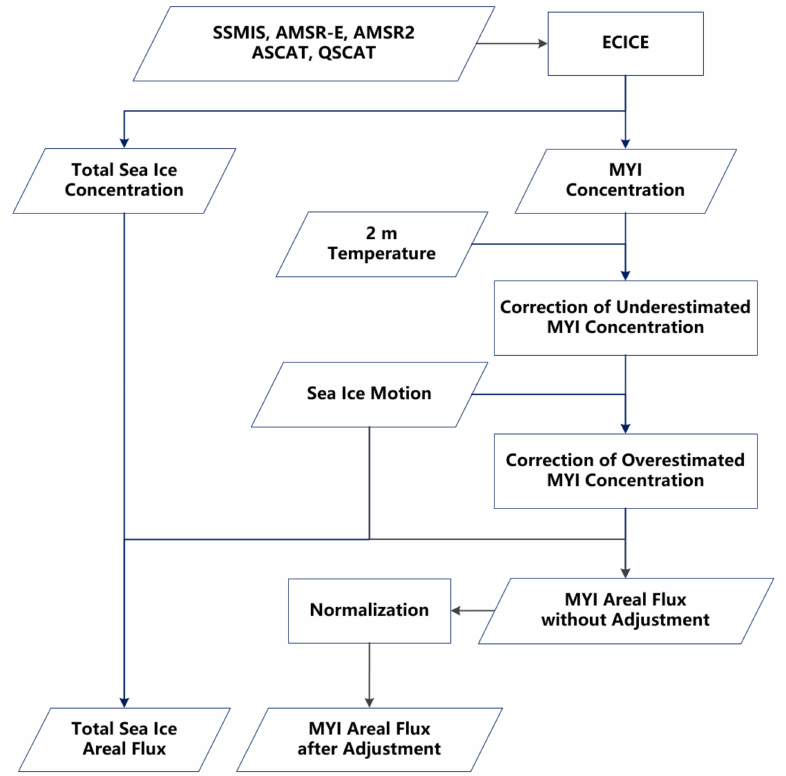
Figure 2. Flowchart of the areal flux